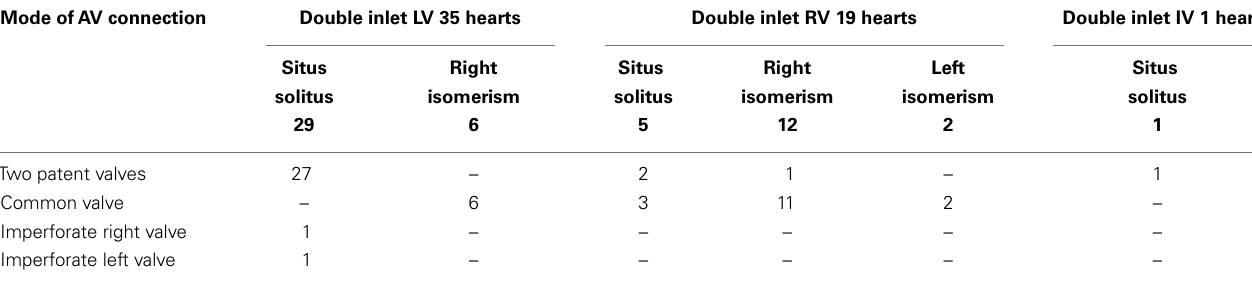
Table 2 | Double inlet ventricle: mode ofAV connection .